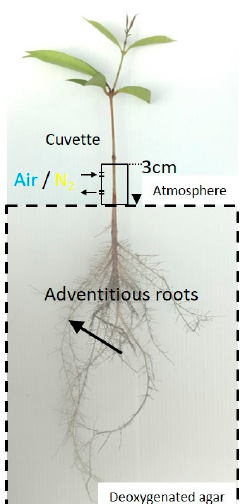
Figure 2. The effect of illumination on the oxygen partial pressure (pO 2 ) in adventitious roots of Syzygium kunstleri . The light condition was controlled during the injection of air or N 2 in the stem through the cuvette(arrows), 0–3 cm above the water surface. Light and dark conditions were alternately changed at intervals of 30 min. The root system was fixed with deoxygenated solid agar (1.5 % w/v ). Arrow: measurement point; arrowhead: water level.